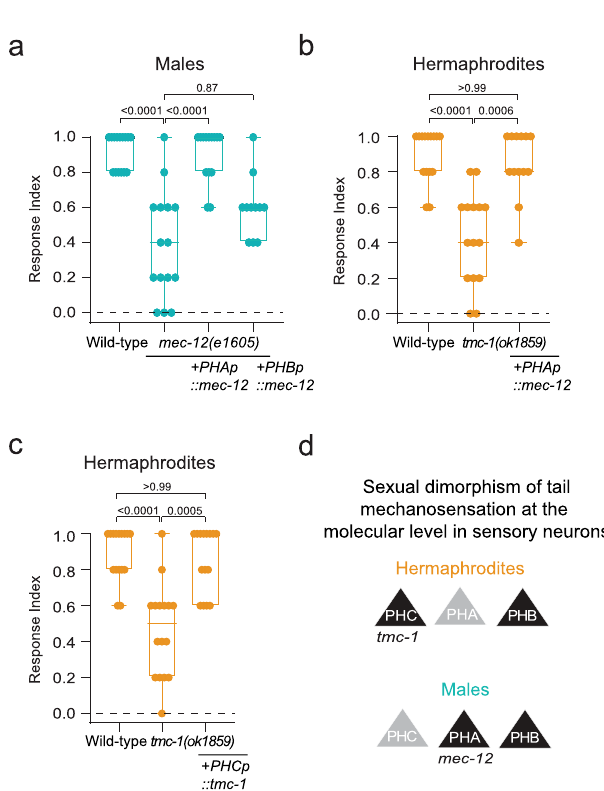
Fig. 2 | mec-12 and tmc-1 function cell- and sex-speci fi cally in tail mechan- osensation.a Tail-touchresponsesofwild-type( n =15), mec-12(e1605) ( n =15) ,mec- 12(e1605);PHAp::mec-12 ( n =14) and mec-12(e1605);PHBp::mec-12 ( n =11) males. b Tail-touch responses of wild-type ( n =15), tmc-1(ok1859) ( n =15) and tmc- 1(ok1859);PHAp::mec-12 ( n =13)hermaphrodites. c Tail-touchresponsesofwild-type ( n =16), tmc-1(ok1859) ( n =16) and tmc-1(ok1859);PHCp::tmc-1 ( n =15) hermaphro- dites. The response index represents an average of the forward responses (scored as responded or not responded) in fi ve assays for each animal. We performed a Kruskal-Wallis test followed by a Dunn ’ s multiple comparison test for all compar- isons. Orange- hermaphrodites, cyan- males. d Schematic of the sensory neurons which function in each sex, with the respective sites of action of tmc-1 and mec-12